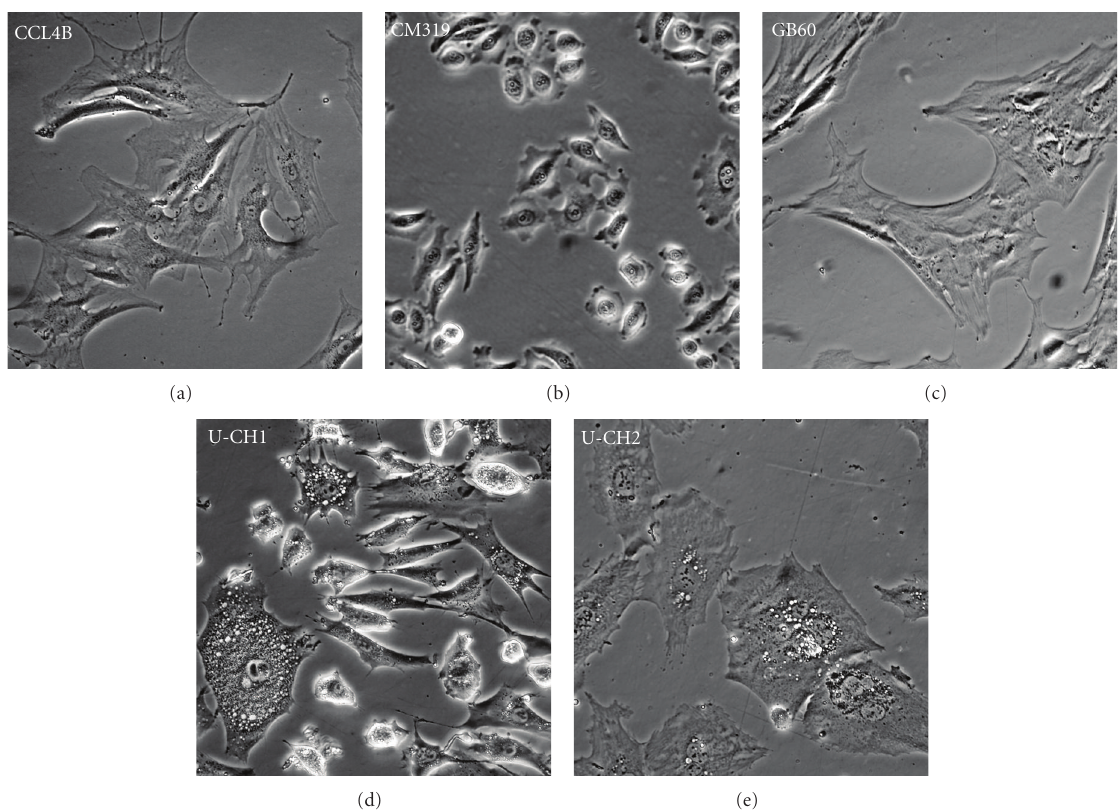
Figure 1: Morphological appearance of putative chordoma cell lines in culture. Phase contrast photomicrographs of cultured CCL4B, CM319, GB60, U-CH1, and U-CH2 show the chordoma tumor-like physaliphorous phenotype in only U-CH1 and U-CH2 cells.